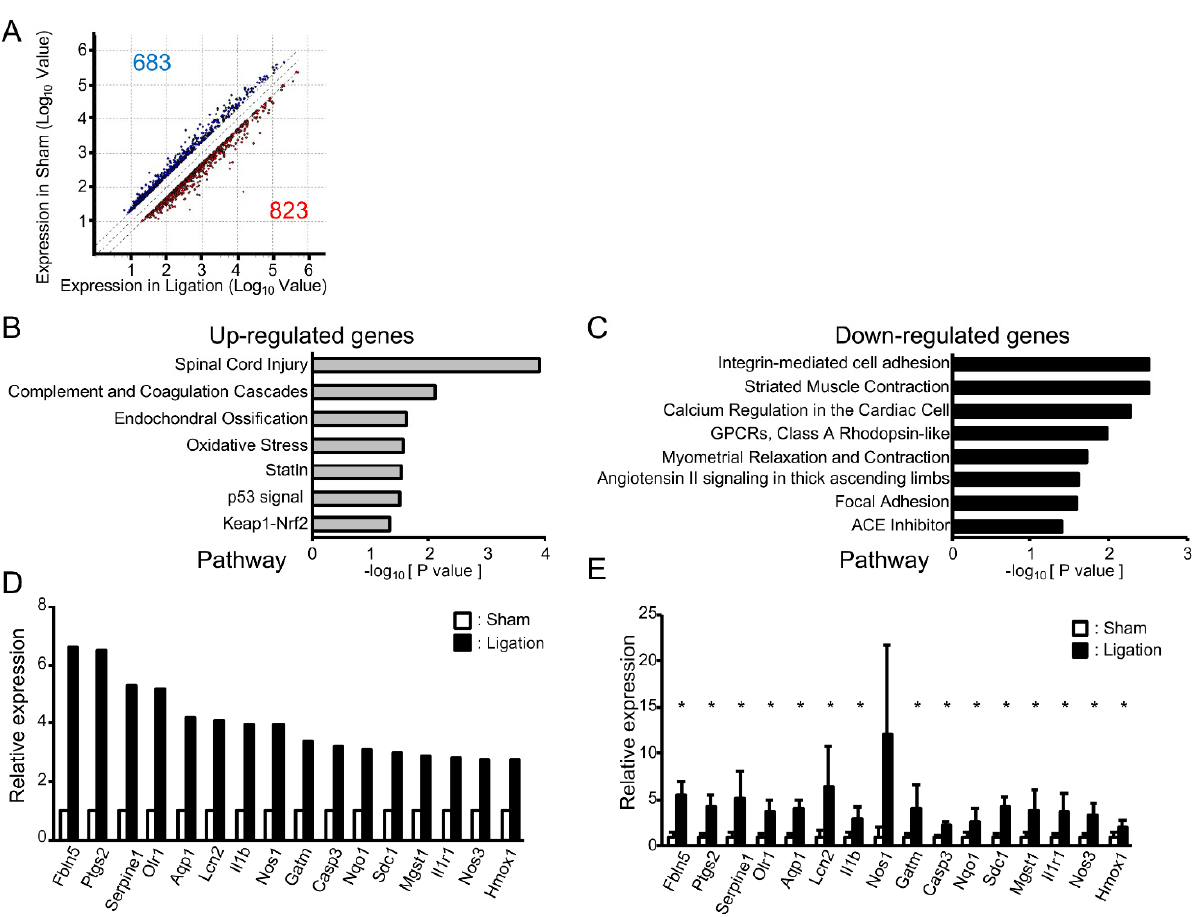
Figure 2. Vascular tortuosity is accompanied by upregulation of oxidative stress-related genes in rats: ( A ) Scattered plot of up- and downregulated genes in bilateral CCA ligated rat; ( B , C ) Pathways enriched among up- and downregulated genes in ligated rat; ( D ) Microarray analysis of oxidative stress-related genes that are upregulated in bilateral CCA ligated rat; ( E ) Real-time PCR analysis of oxidative stress-related genes. n = 4 for each group. Data are expressed as mean and SD. * p < 0.05.